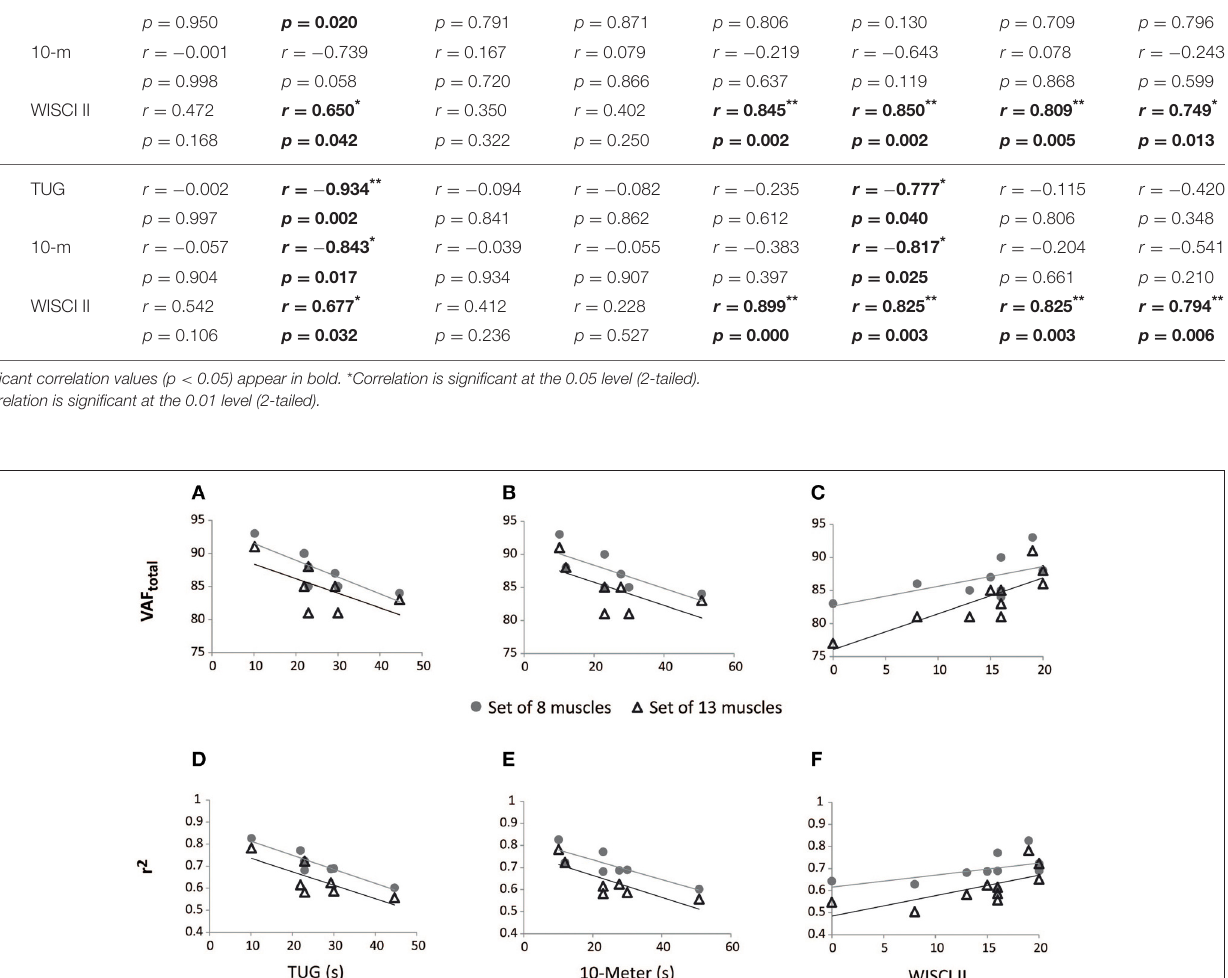
negatively ( p < 0.05, r s < 0) with Penn scale for all speeds, except for 50 rpm ( p = 0.076; see Table 6 ). W3 · W 0 3